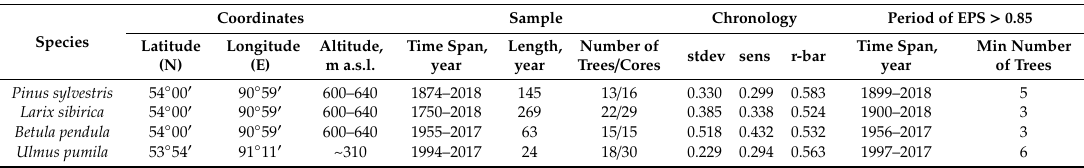
Table 1. Sampling sites and the standard tree-ring width chronologies’ statistics, namely: standard deviation (Stdev), mean sensitivity coefficient (Sens) [34], mean inter-serial correlation coefficient (R-bar), and expressed population signal (EPS) [35].